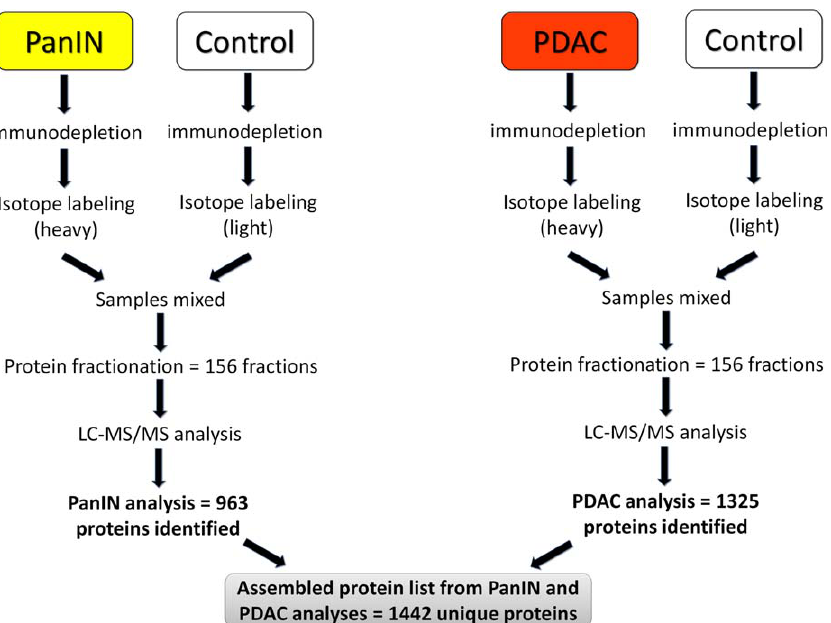
Figure 2. Schematic of Mouse Plasma Proteomic Analysis Pools of plasma from PanIN and PDAC mice along with corresponding controls were similarly processed and combined after differential isotopic labeling. Subsequent protein fractionation involved anion-exchange and reversed-phase chromatography. Individual fractions were analyzed by LC– MS/MS after in-solution digestion. Data were processed using Computational Proteomics Analysis System (CPAS).